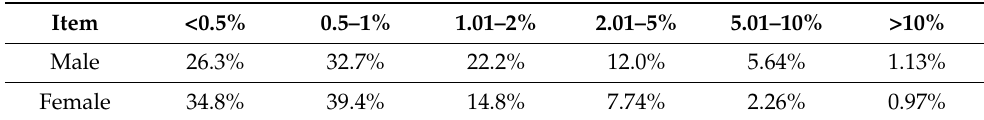
Table 10. Regarding the premium of green express packaging, the relationship between gender and acceptance.